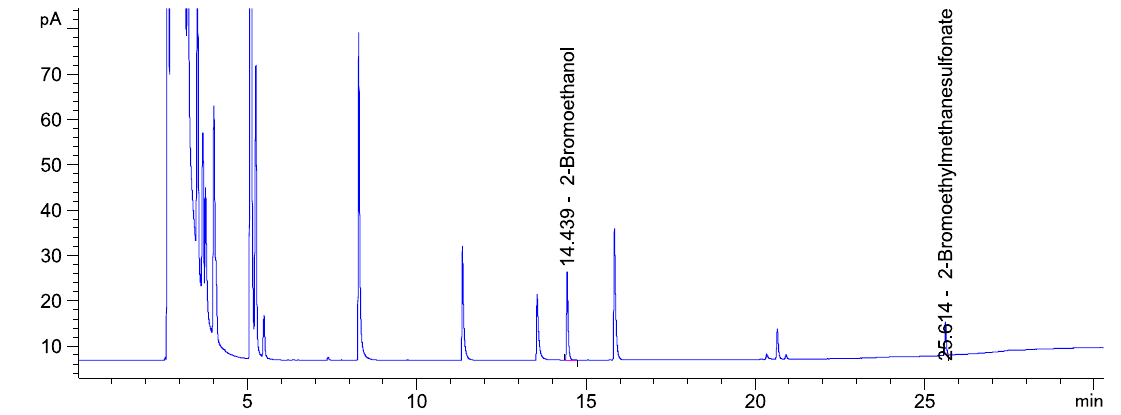
Fig. 4 Chromatogram of Silodosin spiked with residual solvents, 2-BE, and